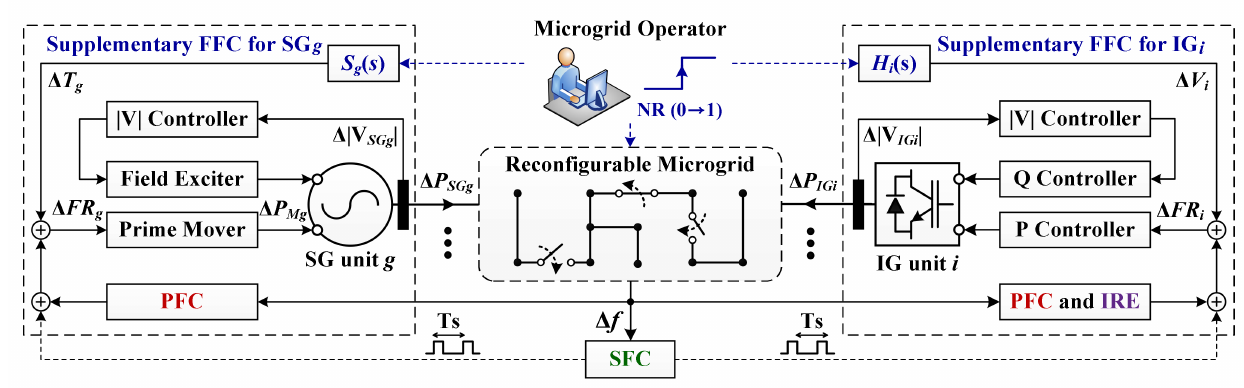
Figure 9. Schematic of a proposed FR strategy for an islanded, reconfigurable